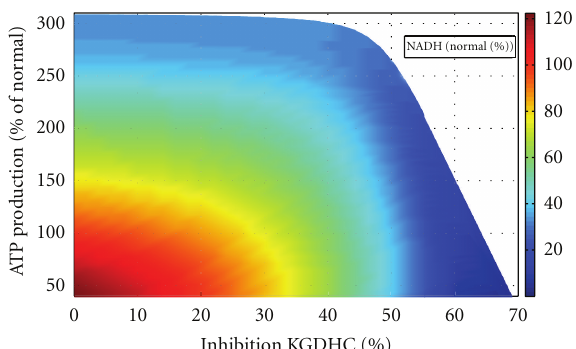
Figure 9: NADH level comparison experiment and simulation. Experimental determined NADH level as black points with error bars at di ff erent inhibition levels of KGDHC and aconitase (data from [15]). Di ff erent coloured curves vary in the basal ATP demand of the system from low (blue) to increased (black). Green curves are for the ATP demand of the reference state. NADH levels are normalized to the NADH level without enzyme inhibition respective to the ATP